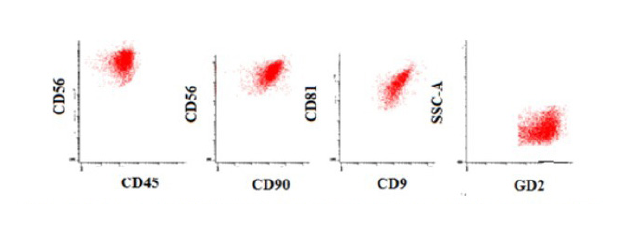
FIGURE 1 – Dot plot diagrams illustrating the neuroblastoma population, whose phenotype is represented by CD45 - /CD56 +strong /CD90 + /CD81 + /CD9 + /GD2 + Source: Ferreira-Facio et al. (2013) (33)